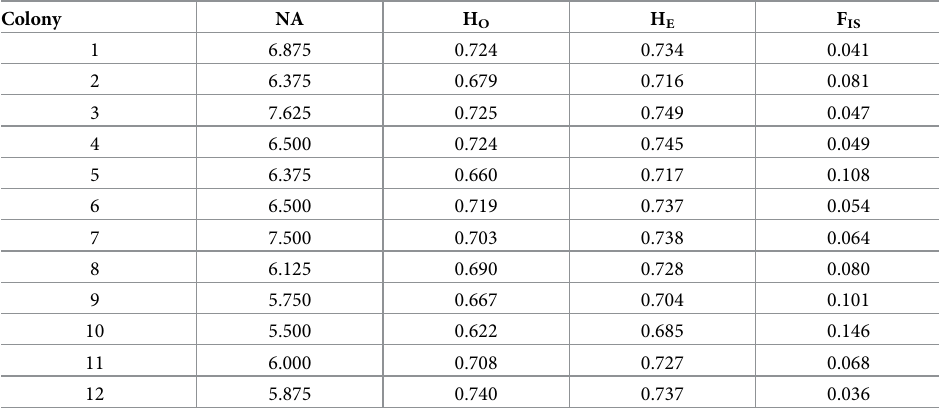
N A − number of different alleles averaged over loci, H O − observed heterozygosity, H E − expected heterozygosity, F IS − inbreeding